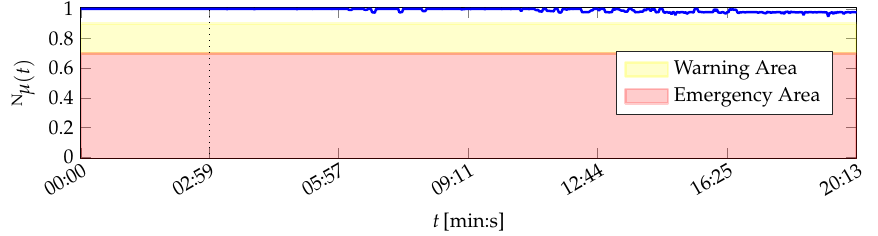
Figure 5. Evaluations of the system health N µ over time during static operation of the printing